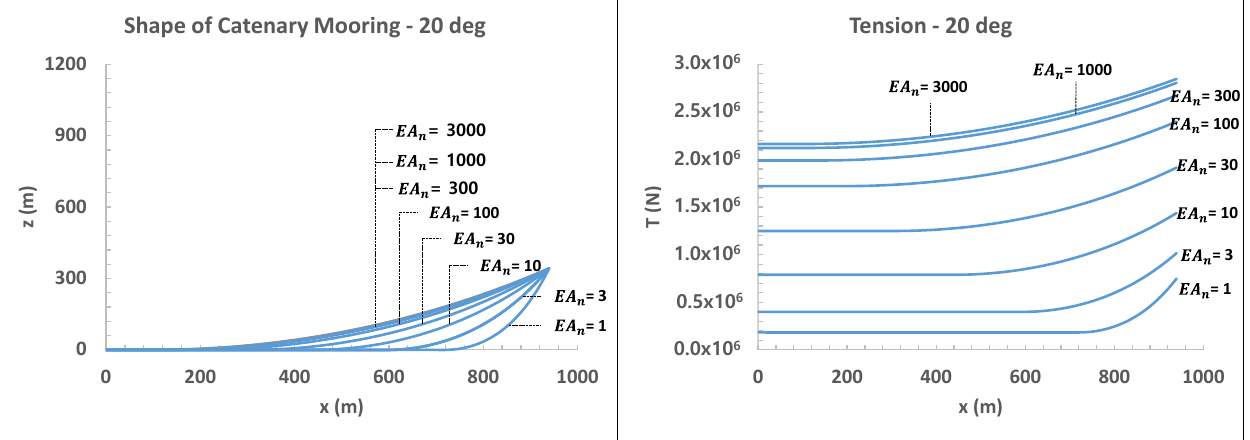
Figure 9. Results for static analysis of mooring line considering seabed condition when q is 20°.